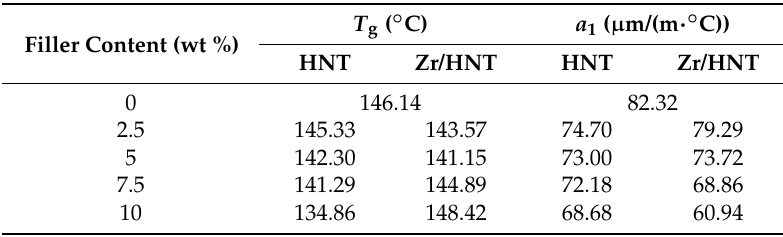
Figure 7. Dimensional change curves for epoxy composites with ( a ) HNT and ( b ) Zr/HNT fillers at different filler contents. Table 2. Thermal properties of the epoxy composites with different fillers and filler contents from TMA analysis ( a 1 : CTE below T g ).